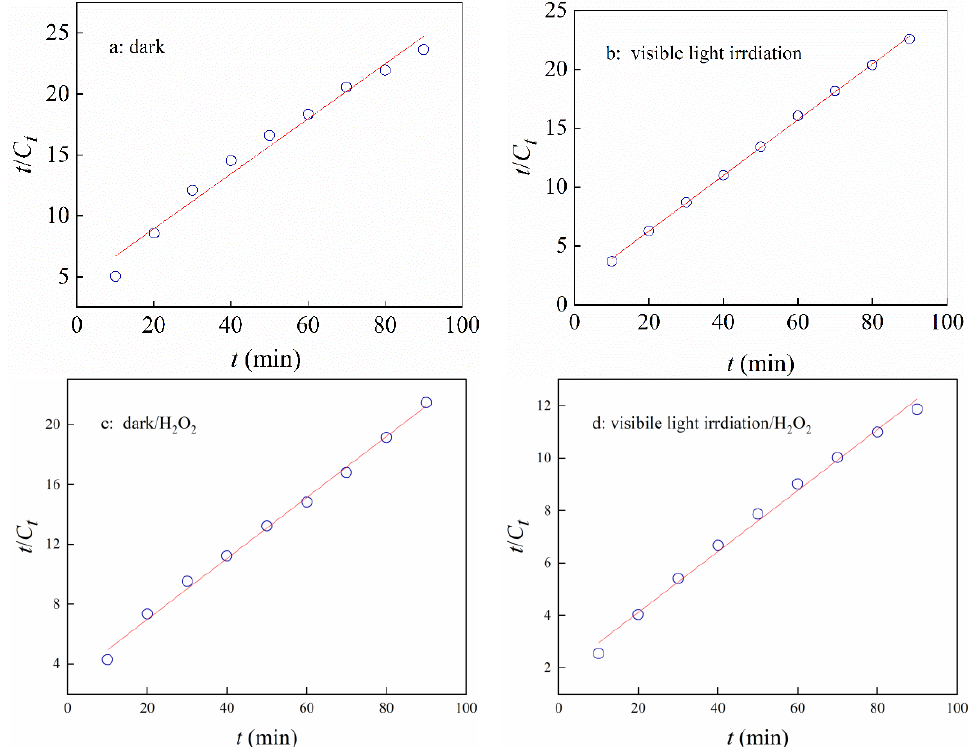
Figure 10. Pseudo-second-order equation plots of n-hemin/PAN: ( a ) dark without H 2 O 2 , ( b ) light